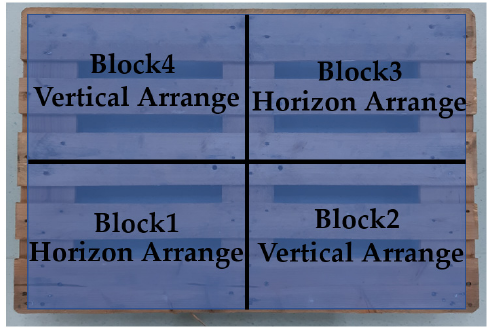
Figure 1. Symmetrical arrangement area division.